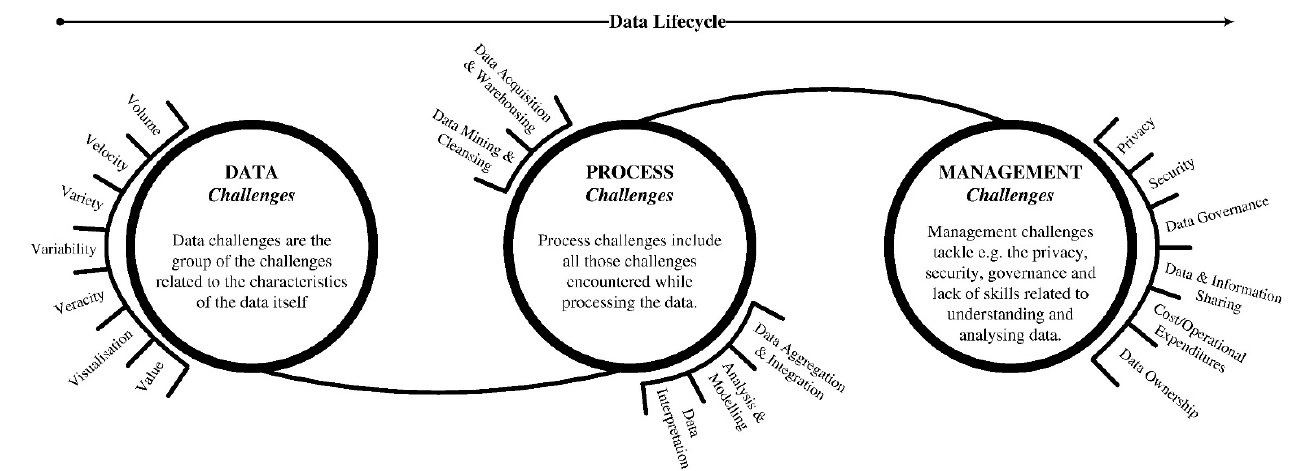
Fig. 1. Big data intellectual challenges